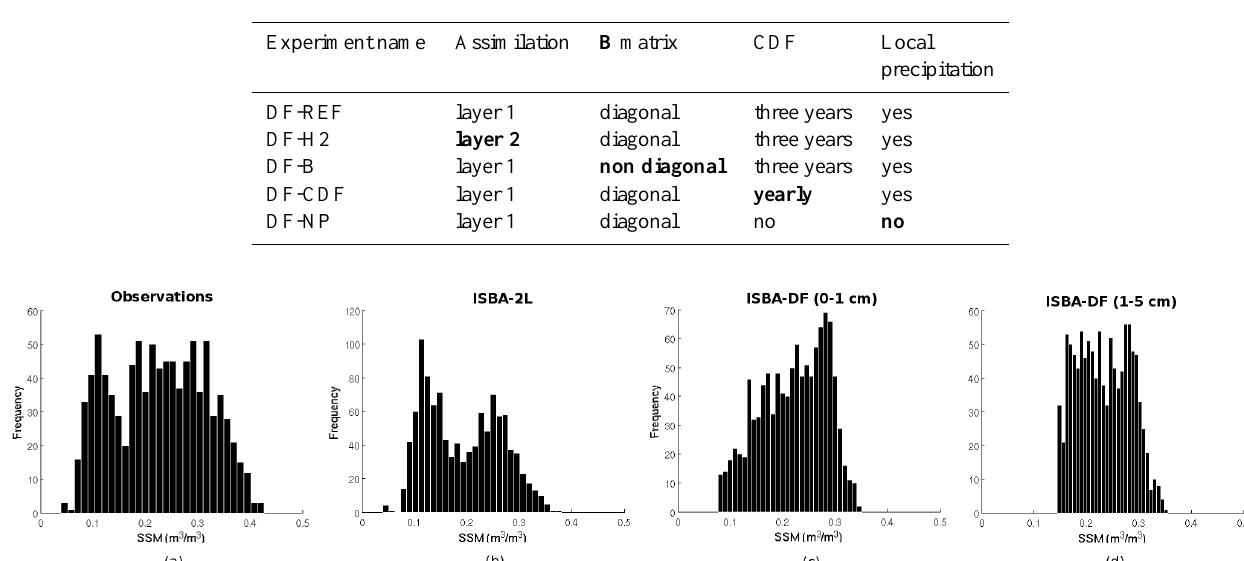
Fig. 2. (a) SSM observations (0–6cm), (b) w 1 modeled by the ISBA-2L LSM, (c) w 1 and (d) w 2 simulated by ISBA-DF LSM frequency distribution at the SMOSREX site from 2003 to